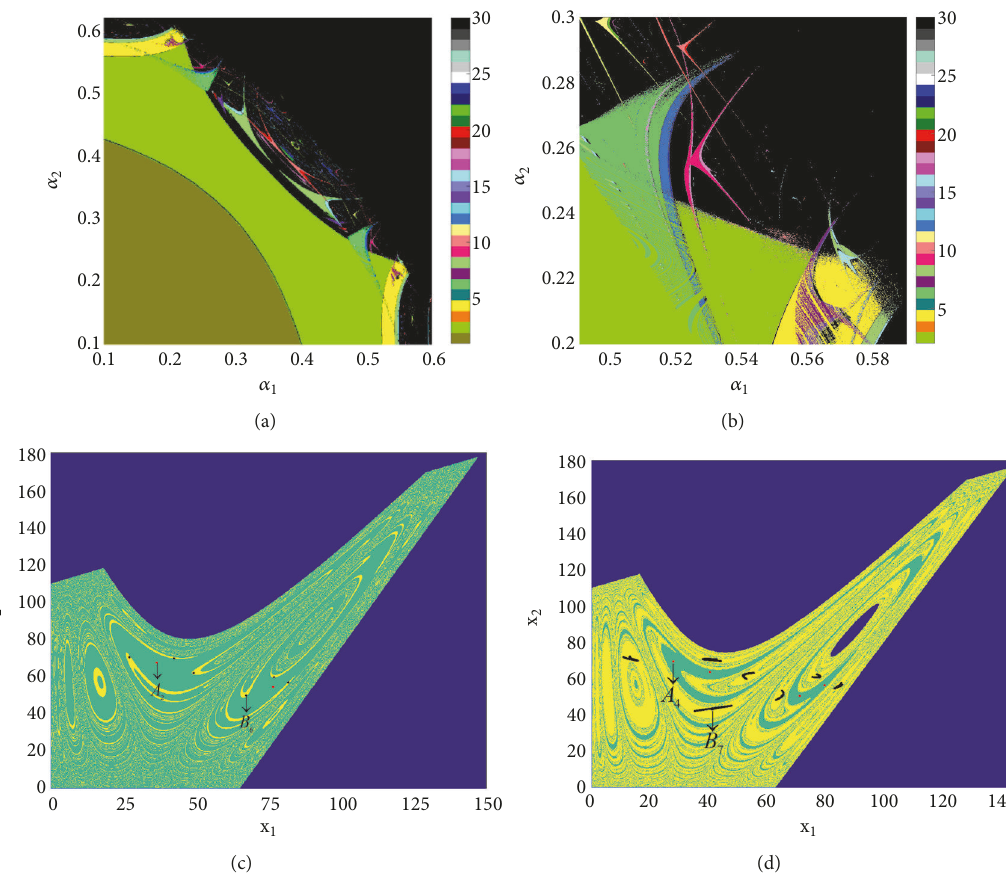
Figure 11: (a) The two-parameter bifurcation diagram in the parameter plane (𝛼 1 ,𝛼 2 ) with fixed parameters as 𝑎 = 4.19 , 𝑏 = 0.04 , 𝑐 = 0.13 , 𝛽 = 0.32 , and 𝛾 = 0.098 . (b) Partial enlargement of (a). (c) The basin of attraction, where a period-2 cycle coexists with a period-6 cycle when 𝛼 = 0.524 and 𝛼 = 0.2037 . (d) The basin of attraction, where a period-4 cycle coexists with a 7-piece chaotic attractor when 𝛼 1 2 and 𝛼 2 = 0.2037